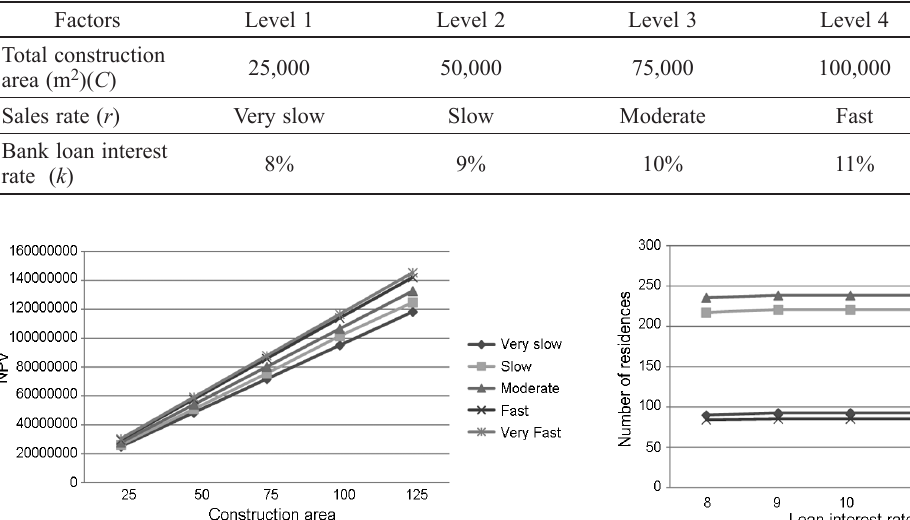
Table 5. Factor levels for experimental design